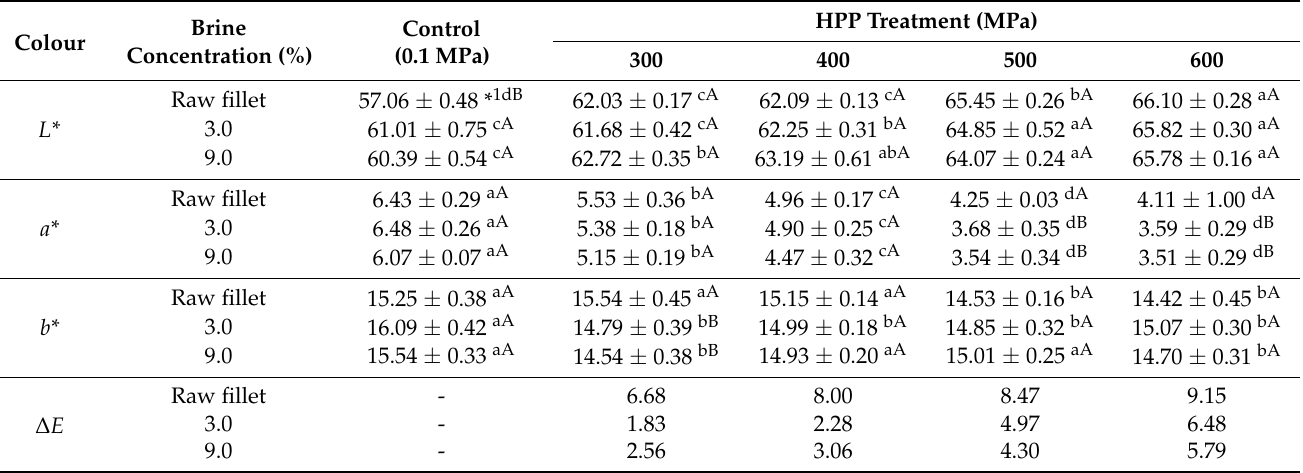
Table 4. The L* , a* , b* , and ∆ E values of mackerel fillets after the brine salting of 3.0% and 9.0% for